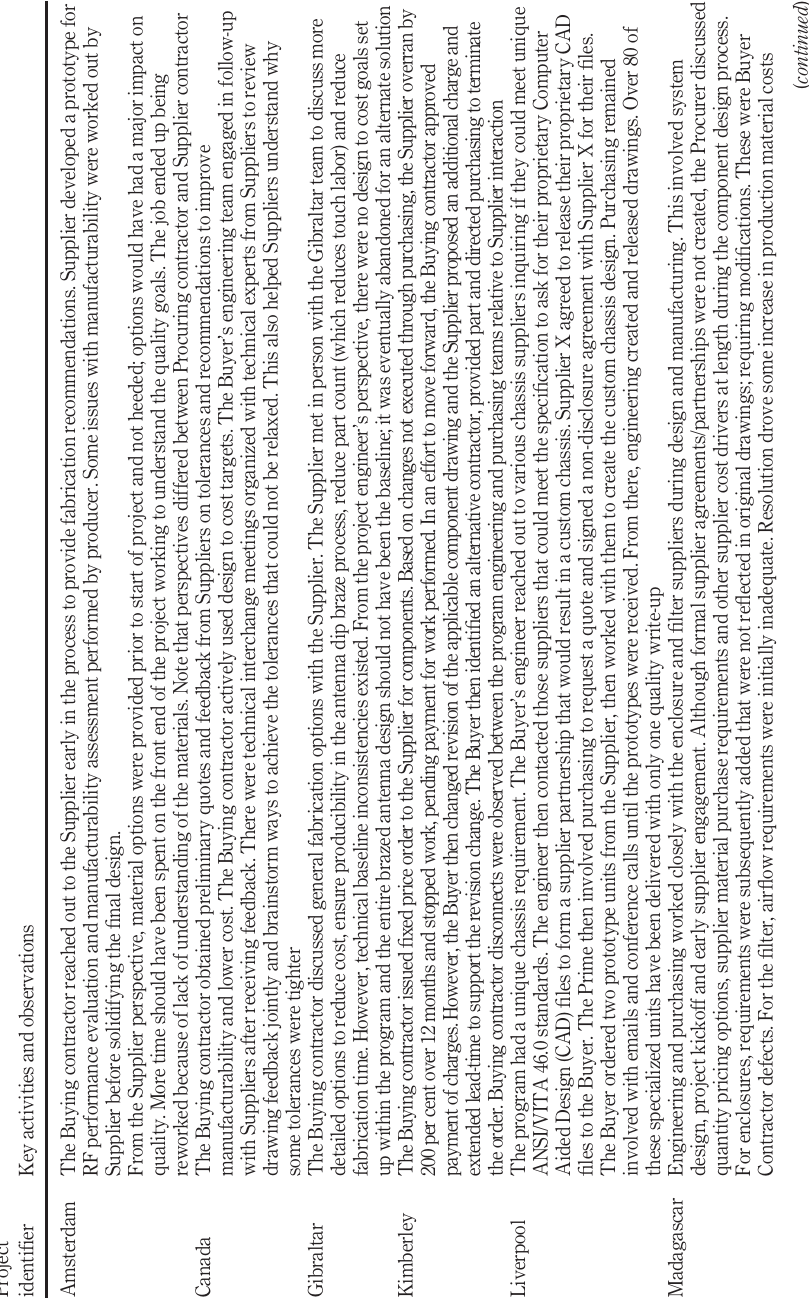
Table VI. Summary of key ESI actions and observations ’